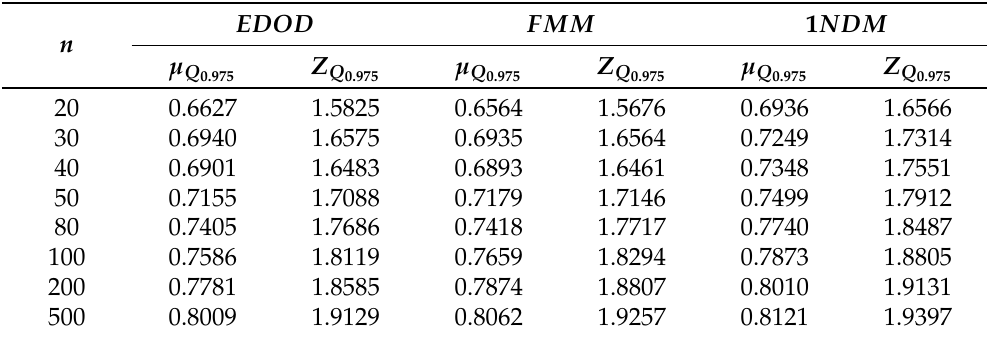
Table 12. Mean of the distribution of 97.5% quantile and its typified value for the Finite Mixture Model ( FMM ), the One Normal Distribution Model (1 NDM ) and the empirical distribution of observed data EDOD (based on 5000